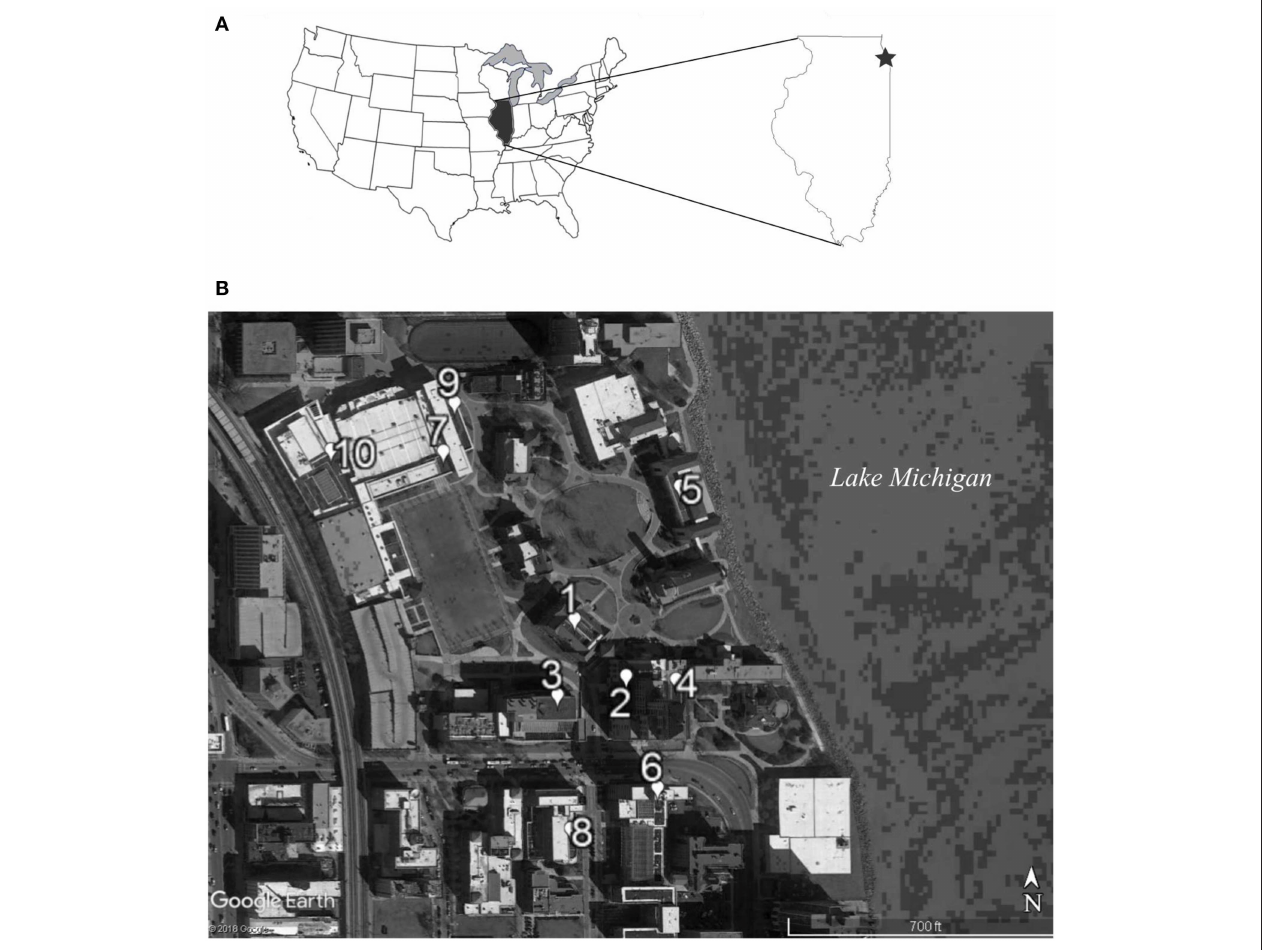
FIGURE 1 | The 10 green roof sites used for the gene flow experiment were located in Chicago, IL USA (A) within a 0.12km area on the western shore of Lake Michigan (B) . Site numbers indicate the degree of proximity to all other sites, with site number 1 having the shortest mean distance to all other sites and site number 10 having the largest mean